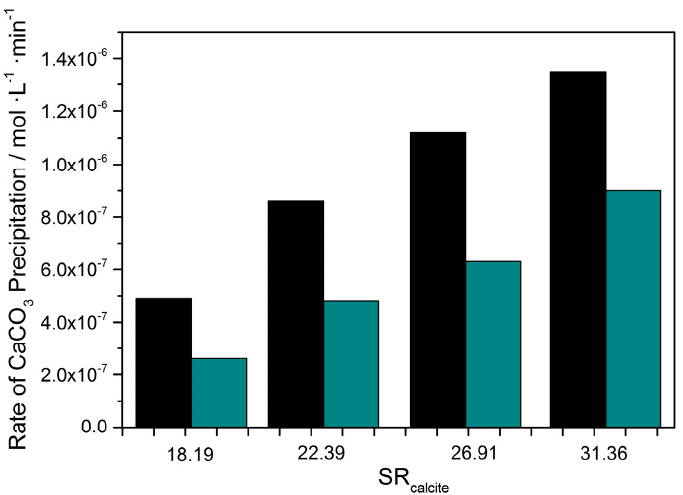
Figure 9. Calcium carbonate precipitation rate as a function of supersaturation ratio; 25 ° C, pH 8.50, 0.15 M of NaCl; ( (cid:4) ) only A. obliquus culture; (green bar) in the presence of 6.0 µ M of Ni and A. obliquus culture.